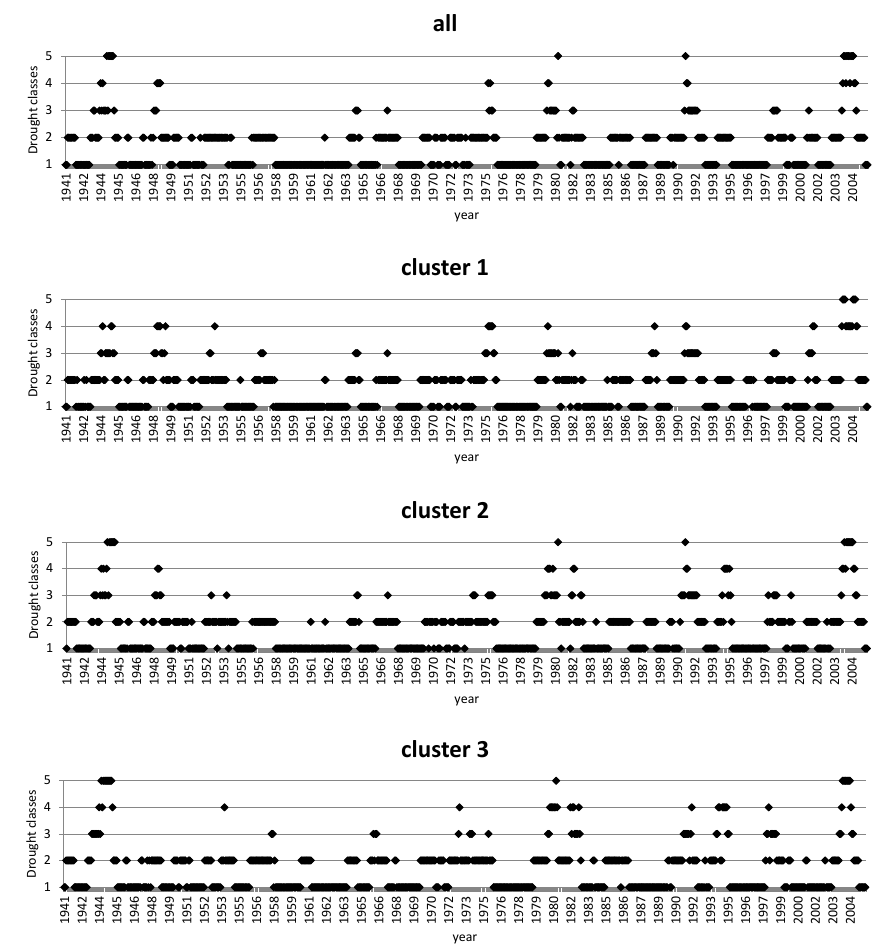
Figure 3. The most frequent drought class by month in Portugal (all), cluster 1, cluster 2 and cluster 3 (1 – non drought, 2 – near normal, 3 – moderate, 4 – severe, 5 –